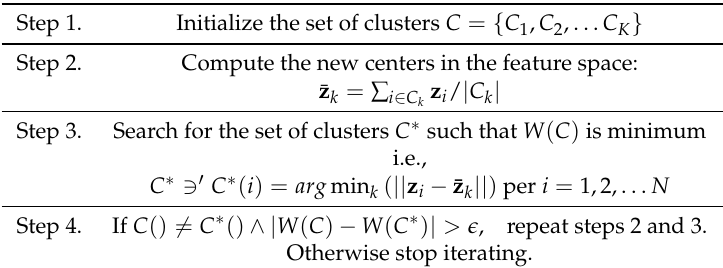
Table 1. Iterative minimization procedure of the function of cost